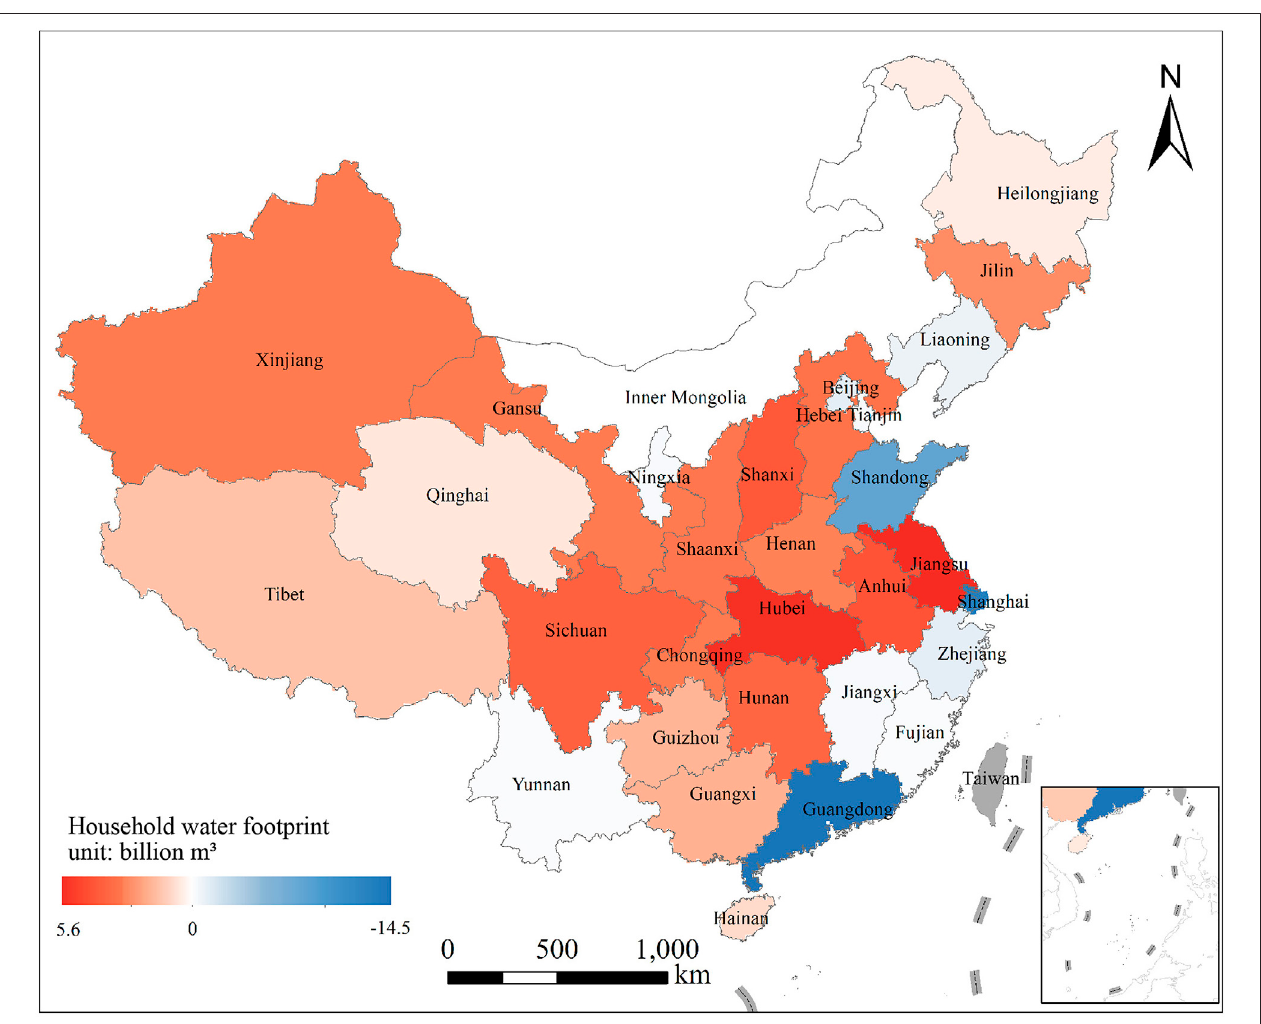
FIGURE 1 | The changes in the household water footprints among